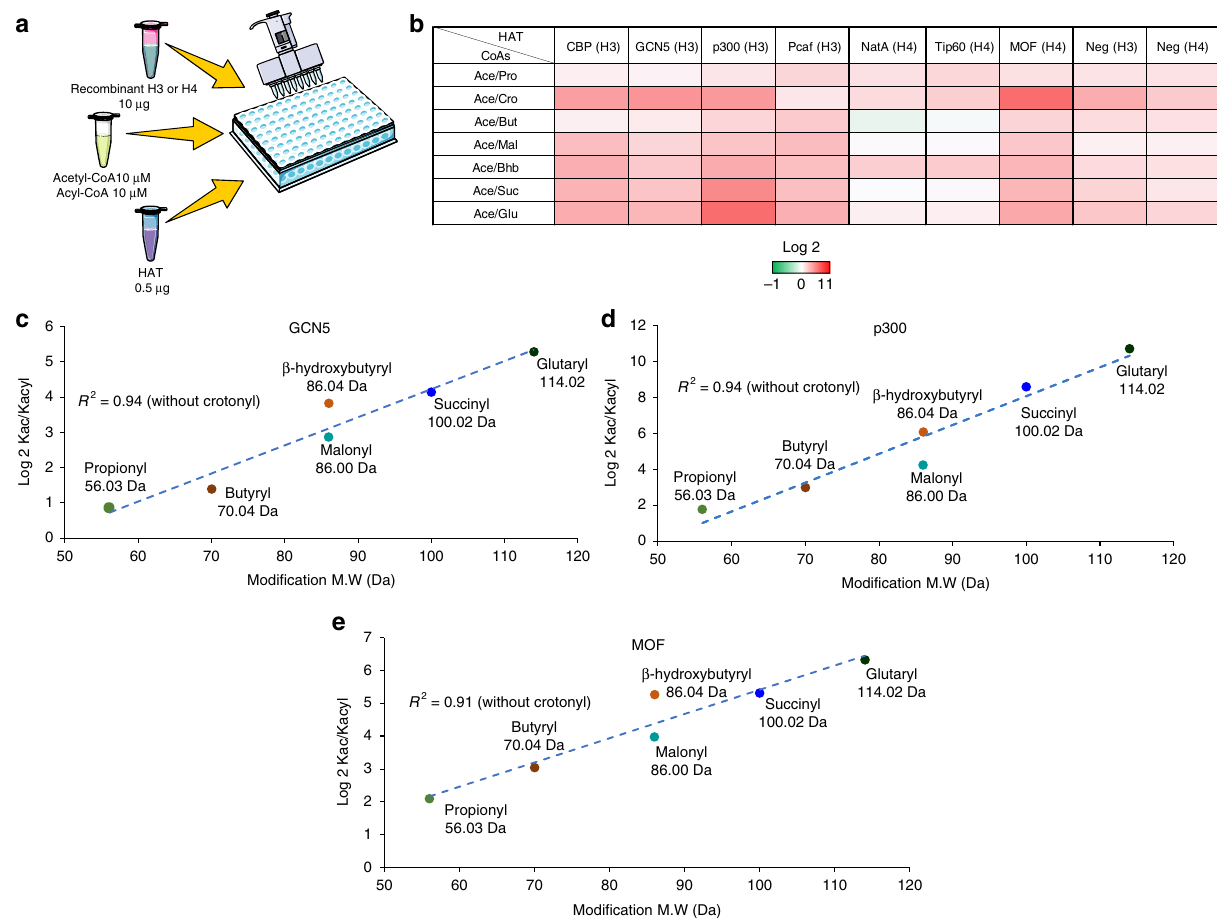
Fig. 3 In vitro acetylation competition assay. a Schematic representation of the in vitro competition acetylation assay. b Heat map displaying in vitro acylation speci fi cities of HATs during acyl-CoA competition assays. Different HATs were assayed against histones H3 or H4 as speci fi ed in the table headers in the presence of equimolar concentrations of acetyl-CoA and a competing acyl-CoA donor. Negative controls with no enzyme are also shown. c Correlation between the molecular weight and the acylation preference for different acyl donors displayed for the HATs GCN5 on histone H3, d p300 on histone H3 and e MOF on histone H4. For each modi fi cation, molecular weight is indicated. Results show that the preference for acetyl-CoA over the other acyl donor tightly correlates with the molecular weight of the acyl donor. Crotonylation was not included in the correlations, as its molecular weight did not correlate well with the preference of the enzymes over acetyl-CoA. All graphs are shown as the average of log2 ratios between the relative abundances of all acetylated peptides and the relative abundances of the corresponding competing acylated